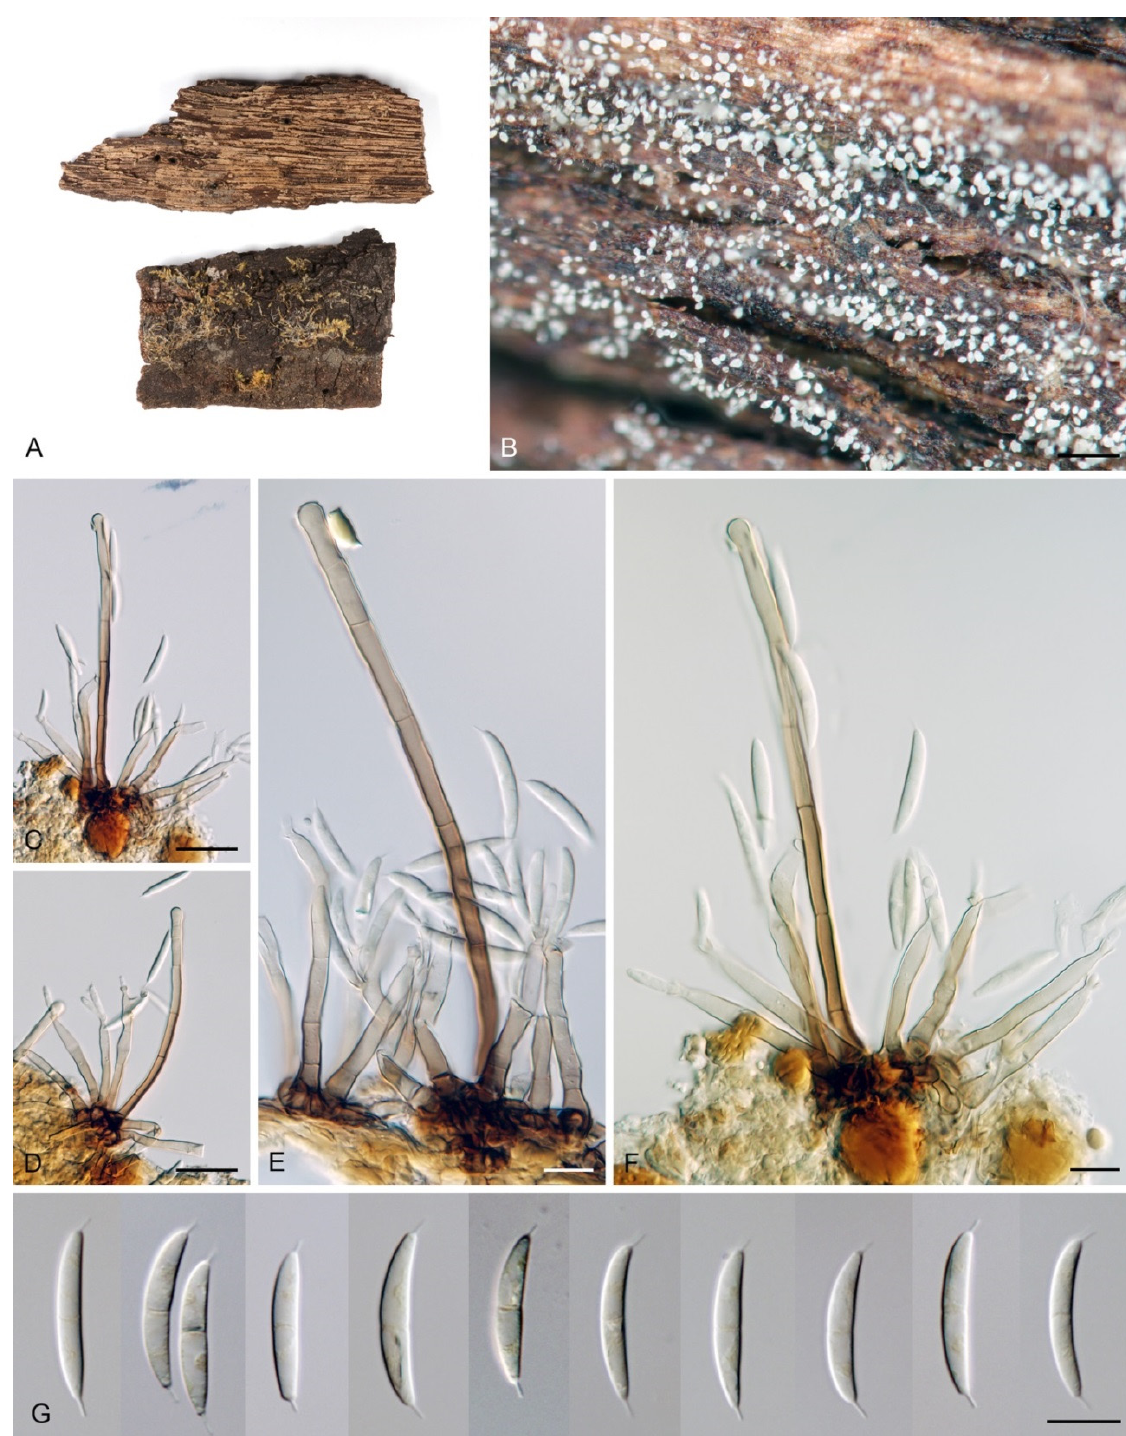
Figure 35. Stilbochaeta brevisetula (DAOM 96420a isotype). ( A ) Substrate with colonies ( B ) colony on wood ( C – F ) setae and conidiophores ( G ) conidia. Images: ( A – G ) from nature. Scale bars: ( B ) 500 μ m; ( C , D ) 25 μ m; ( E – G ) 10 μ m.